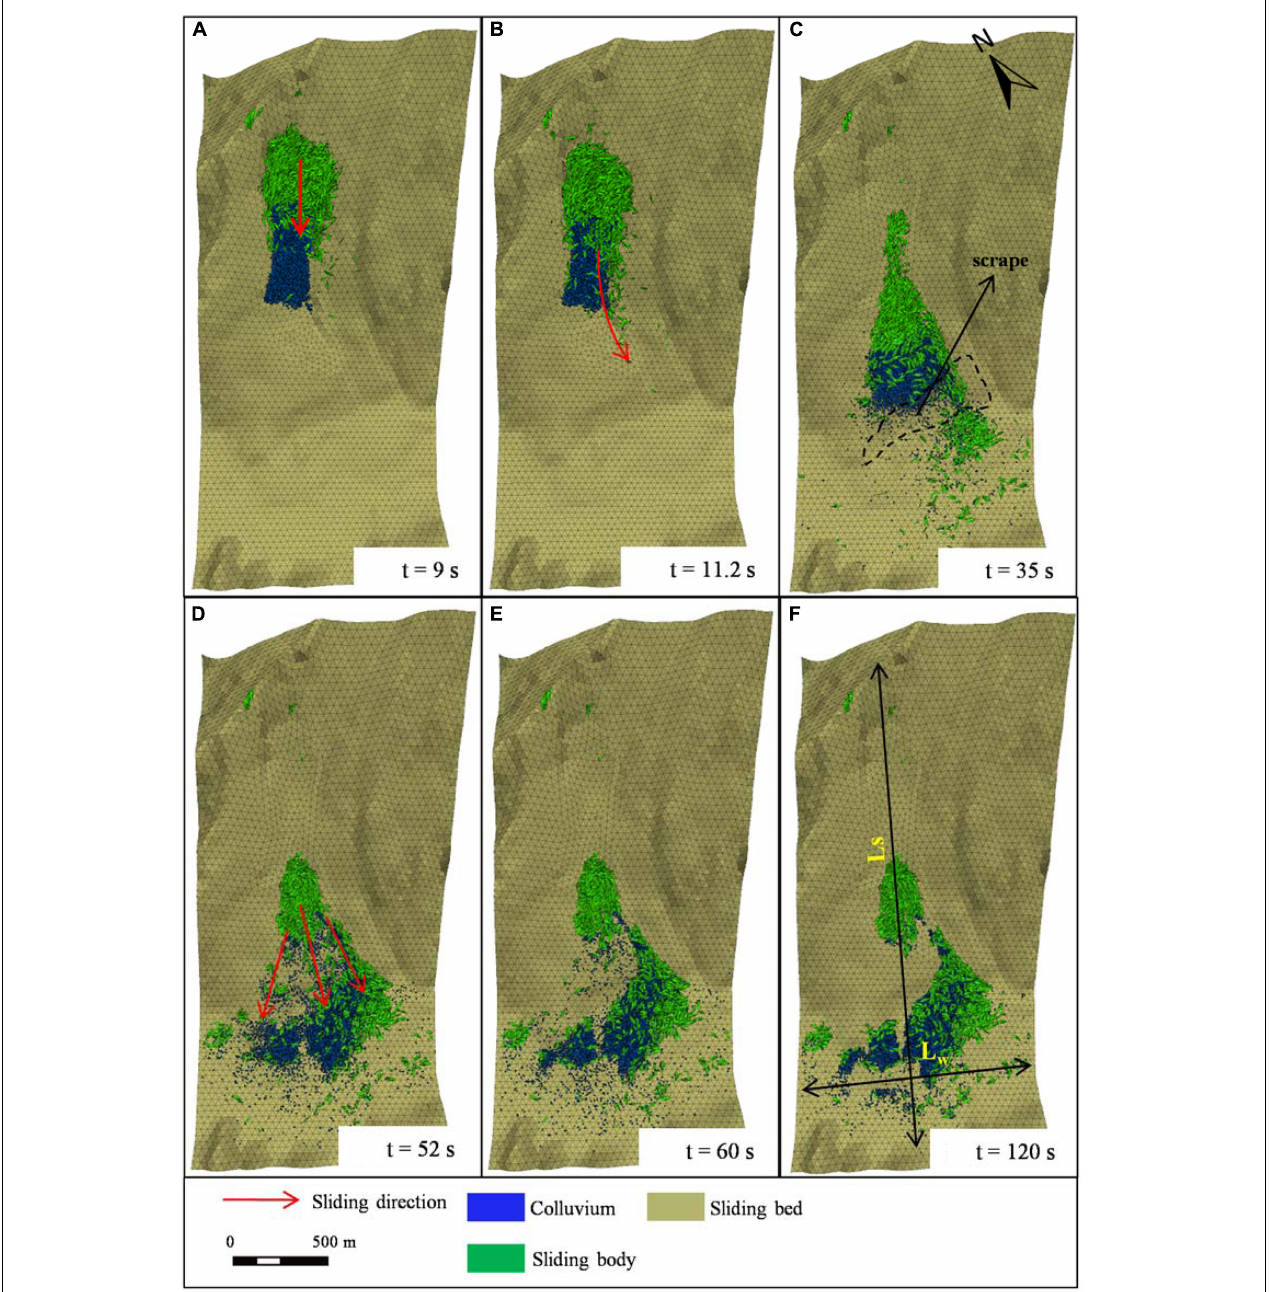
FIGURE 10 | Simulated sliding mass position at different times since the landslide initiation: (A) t = 9 s; (B) t = 11.2 s; (C) t = 35 s; (D) t = 52 s; (E) t = 60 s and (F) t = 120 s. L s and L w indicate the maximum length of the landslide along the direction of motion and down the river,